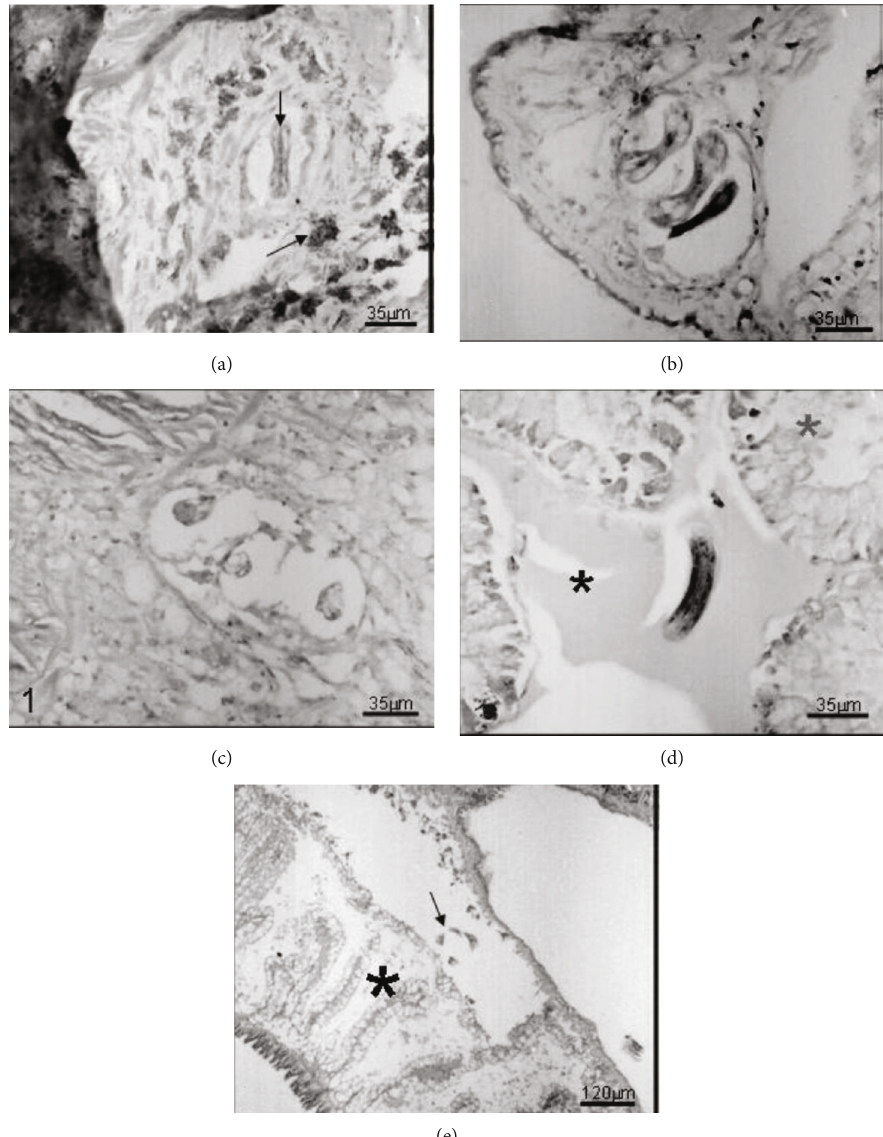
Figure 4: Histological sections of Biomphalaria glabrata infected with 1000 L1 of A. vasorum . Hematoxylin and eosin staining. (a) Larva (vertical arrow) located in the foot fi bromuscular tissue with loss of cellularity and loose appearance of the tissue plus deposit of melanin pigment (oblique arrow) after sixty days of the beginning of infection; (b) larvae (L3) in pedal tissue without evidence of granulomatous structure showing a tissue with very loose aspect sixty days after the beginning of infection; (c) larvae (L3) in conjunctive tissue with loose appearance and presence of well-marked clear space around the larvae sixty days after the beginning of infection; (d) free larva (L3) located in spaces (black asterisk) between the diverticula of the digestive gland (gray asterisk) without the presence of cellularity around after sixty days of the beginning of infection; (e) free larva (arrow) in the renal space (black asterisk) without the presence of cellularity sixty days after the beginning of infection. Magni fi cations: (a – d): 35 μ m; (e): 120 μ